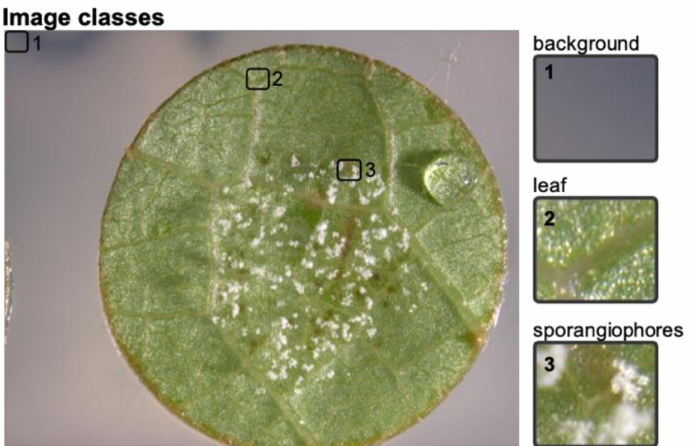
Figure 2. Example leaf disc picture with the three possible classes: 1 background = water agar, 2 leaf = leaf disc partial image without infection, 3 sporangiophores = leaf disc partial image with